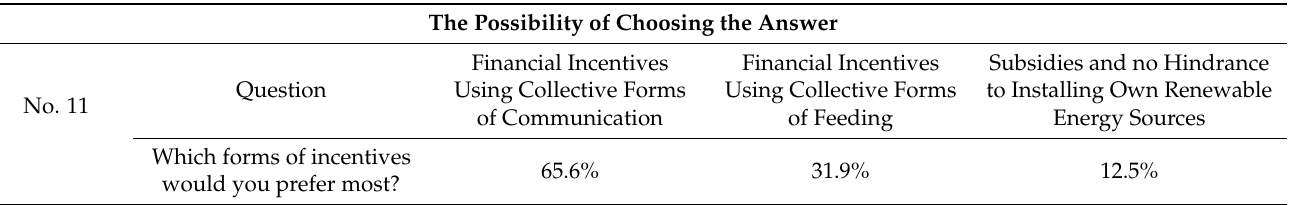
Table 11. Question no. 11, research